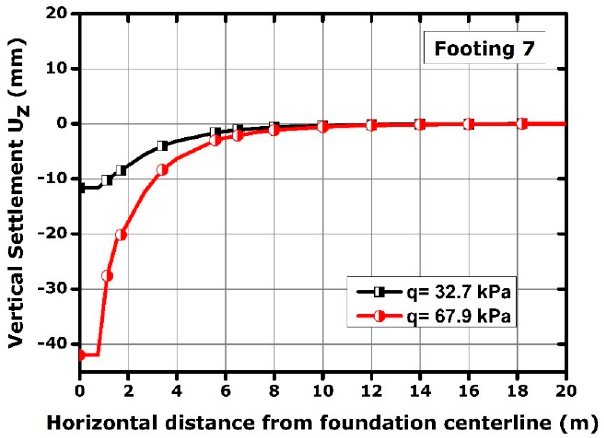
Figure 16. Influence of footing shape on the footing and ground surface settlement in drained conditions–Footing 7.